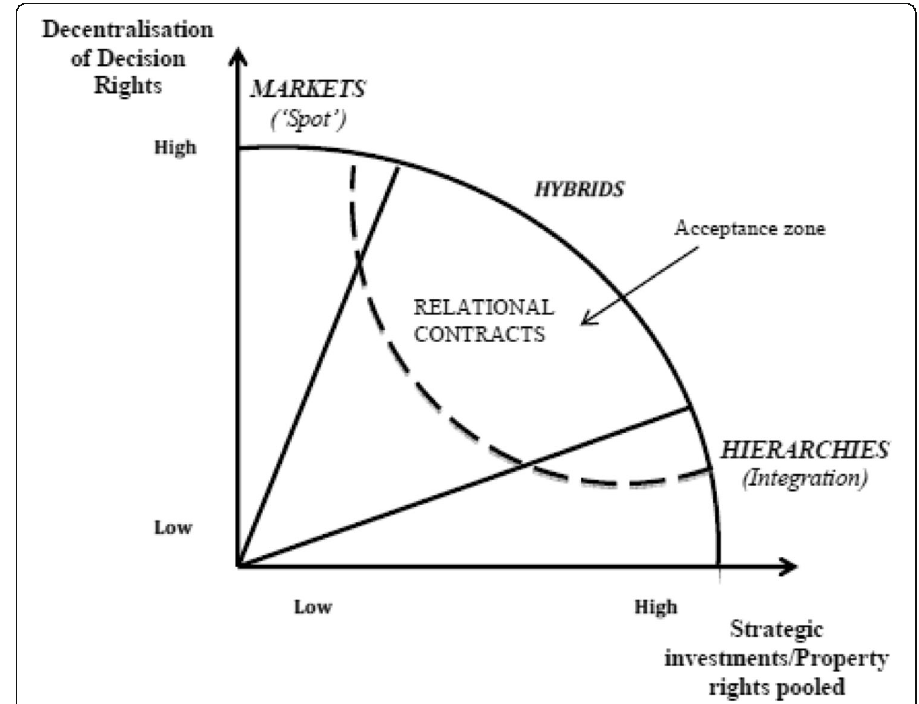
Fig. 2 Firm and corporate governance. Source: Ménard 2013, 2017, 2018 and Martino et al.